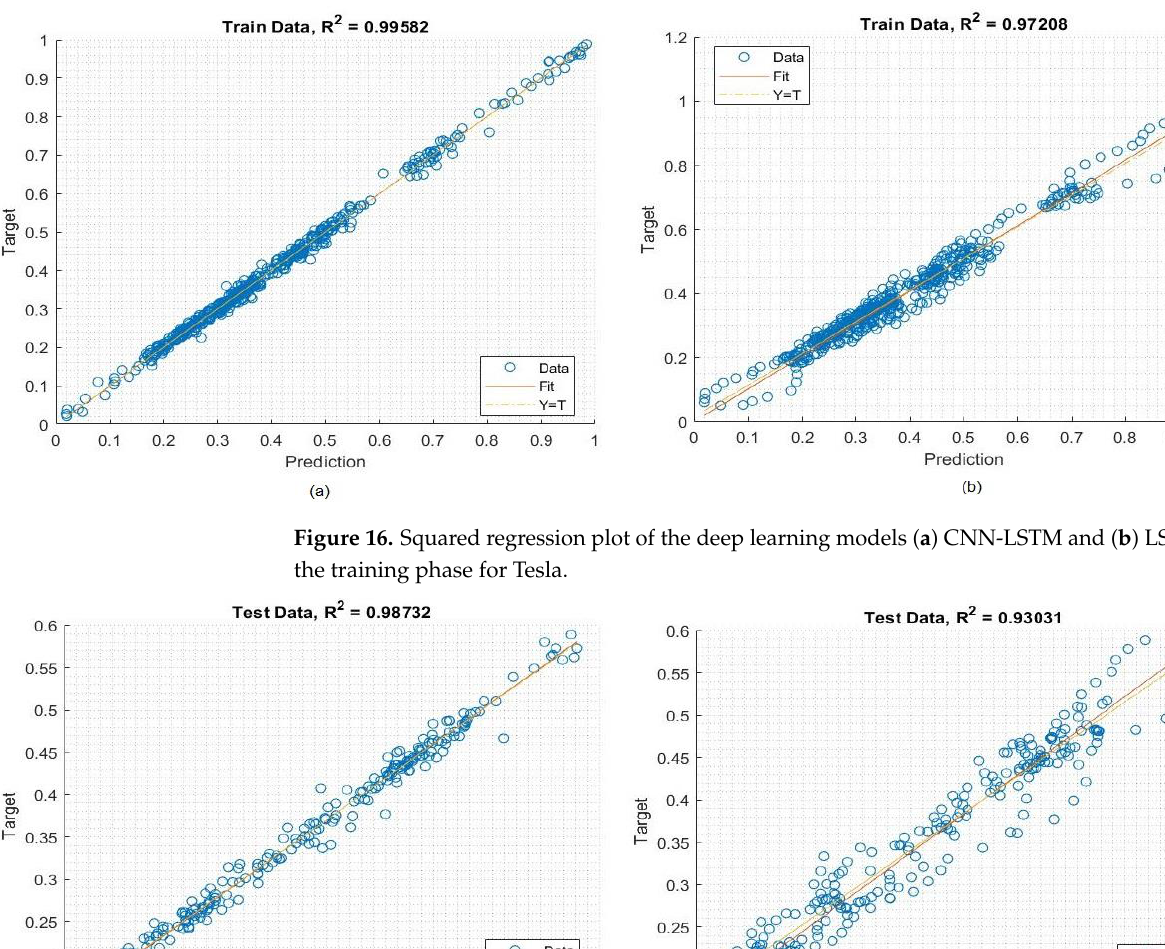
Figure 18. Squared regression plot of the deep learning models ( a ) CNN-LSTM and ( b ) LSTM during the training phase for Apple.